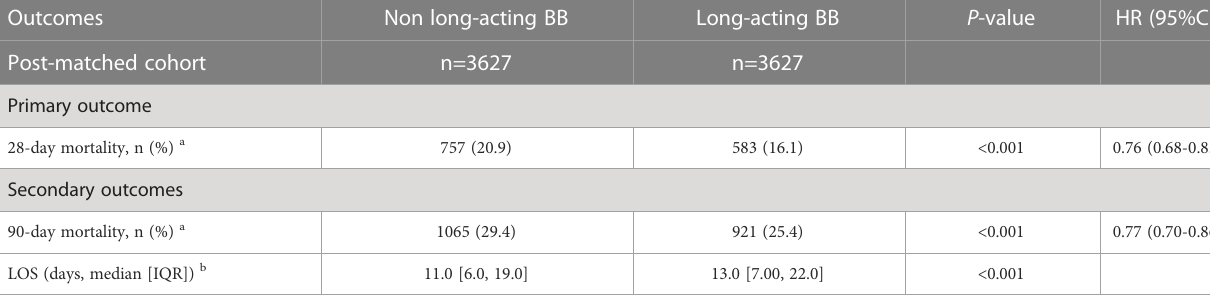
TABLE 4 Association between long-acting b -Blocker therapy and clinical outcomes in